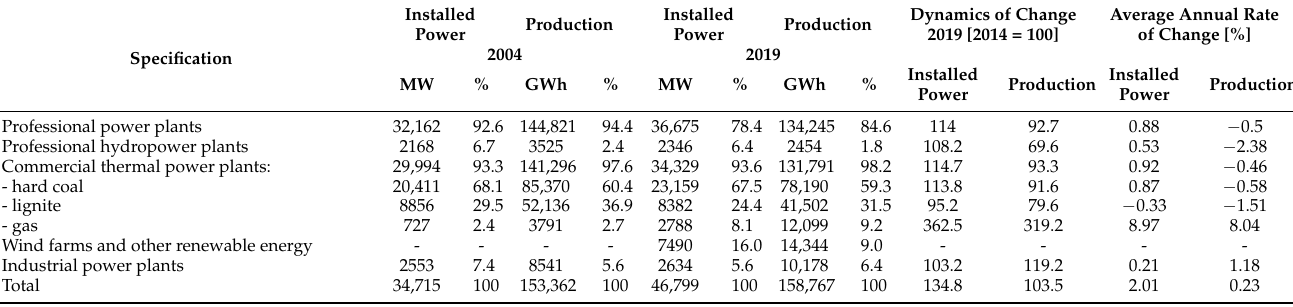
Table 2. The National Electric Power System in Poland in 2004 and